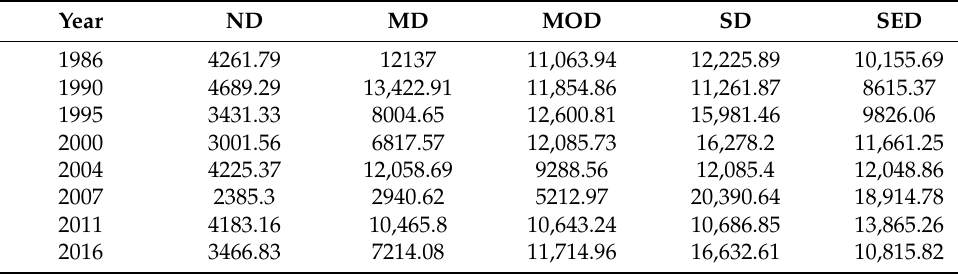
Figure 5. Spatial distribution of desertification types in OSL. Table 2. Area of different levels of desertification in OSL (km²).